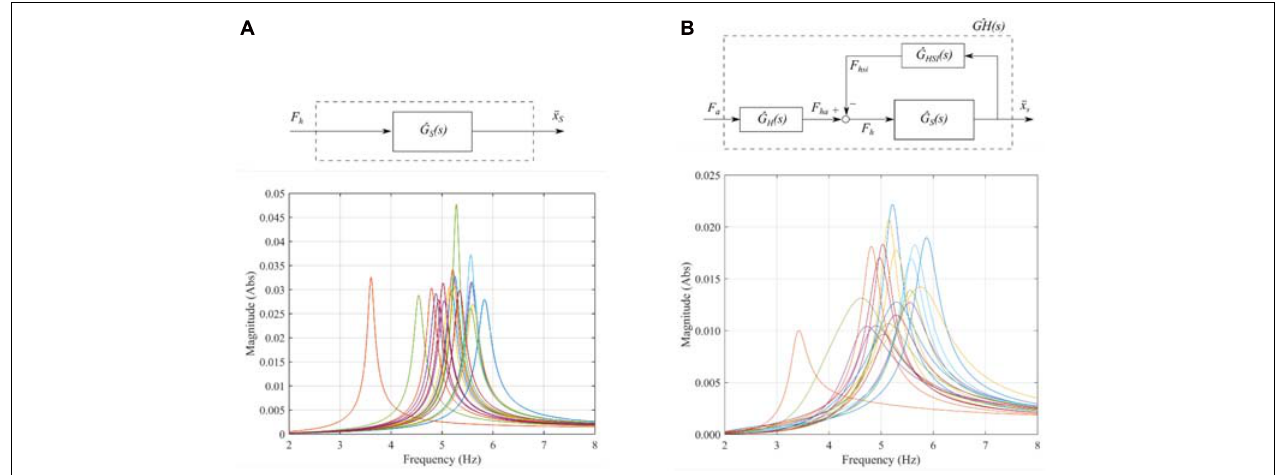
FIGURE 6 | Systems with uncertainties: (A) Block diagram and magnitudes of the TFs of 20 models of the plant, and (B) Block diagram and magnitudes of the TFs of 20 models considering HSI.